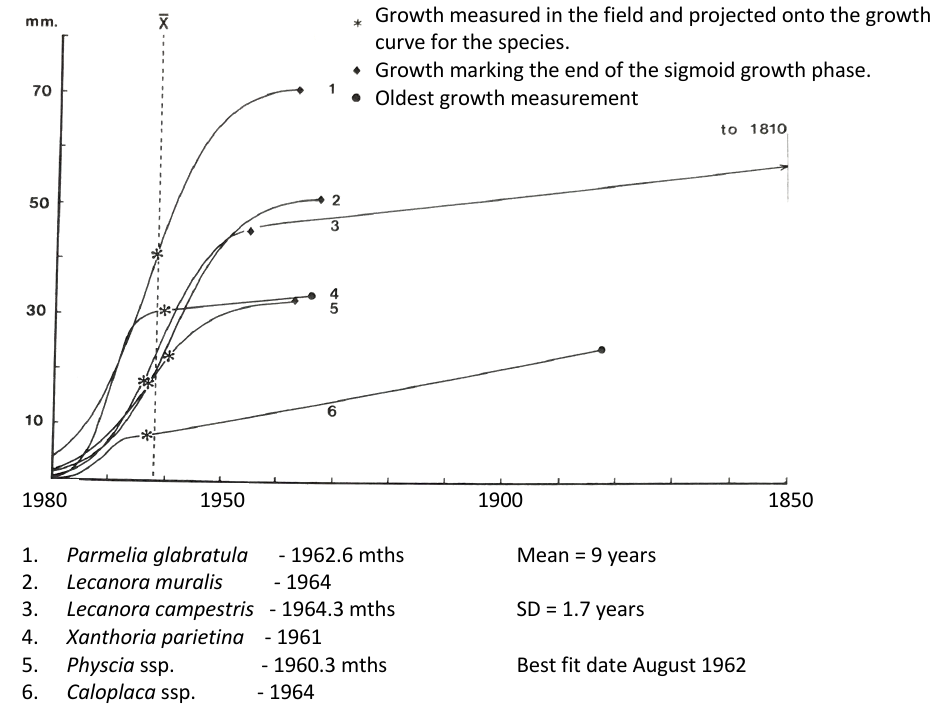
Figure 11. Six species measured in the graveyard at Avebury (*) and used to date when boulders were moved by a farmer to line the bank of a local river Six species measured in the graveyard at Avebury and used to date boulders moved by a farmer to line the bank of a local river (Winchester 1984).